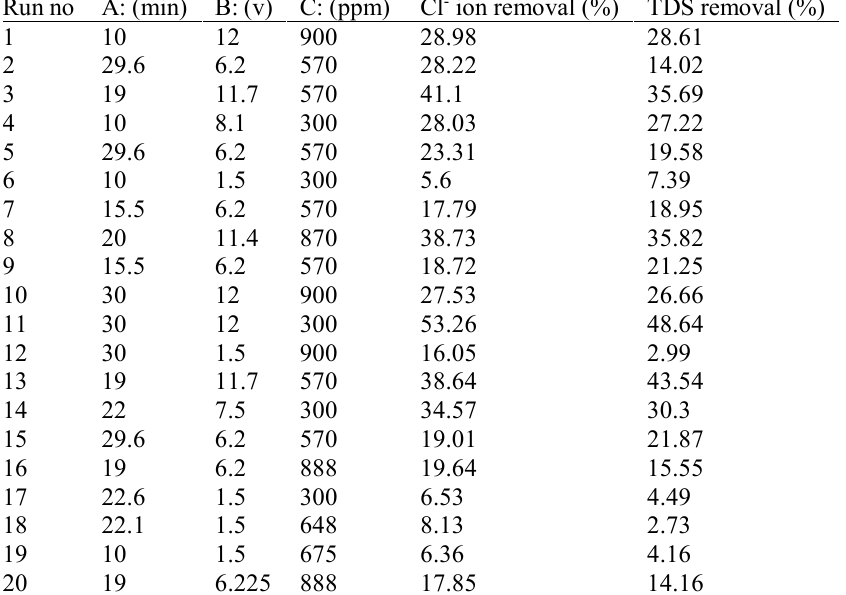
Table 3. Experimental design matrix and response based on experiments conducted on Cl − ion and TDS removal using D-optimal